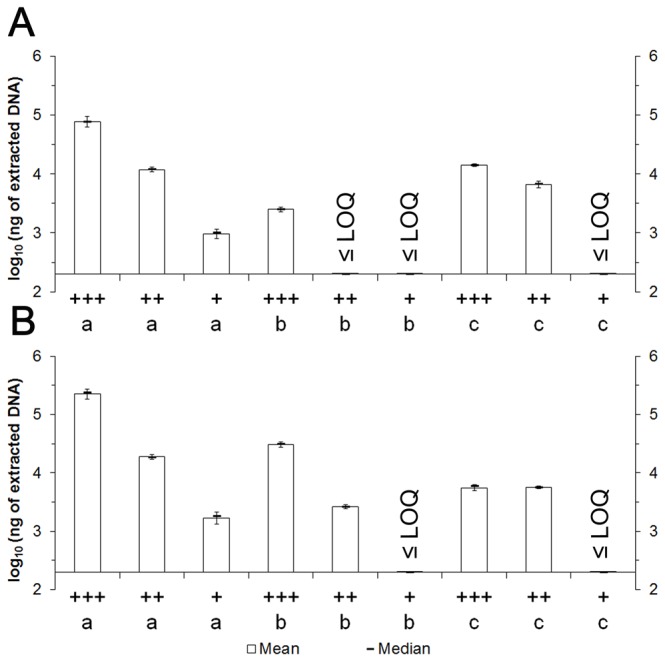
DNA amount measured at 260 nm after DNA extractions (a: van Soolingen procedure, b: Invisorb Spin Tissue Mini Kit from Invitek, c: PowerSoil DNA isolation Kit from MoBio) from big (+++: 10 log10 cells), medium (++: 9 log10 cells), and small (+: 8 log10 cells) pellets of MAP K-10 (A, n=54), and M. tuberculosis H37Ra (B, n=54) cells.Error bars are standard deviation. LOQ are limit of quantification of the spectrophotometer.